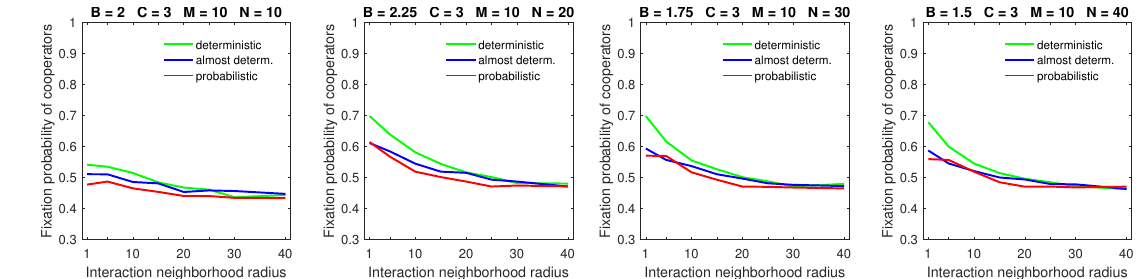
Figure 12. Deterministic dispersal results in higher fixation probabilities of cooperators for a high mobility rate and large dispersal range. The flattening of the fixation probability curves’ effect, which was observed in the probabilistic dispersal case, is weaker in the deterministic dispersal model. In all graphs, R = 5.